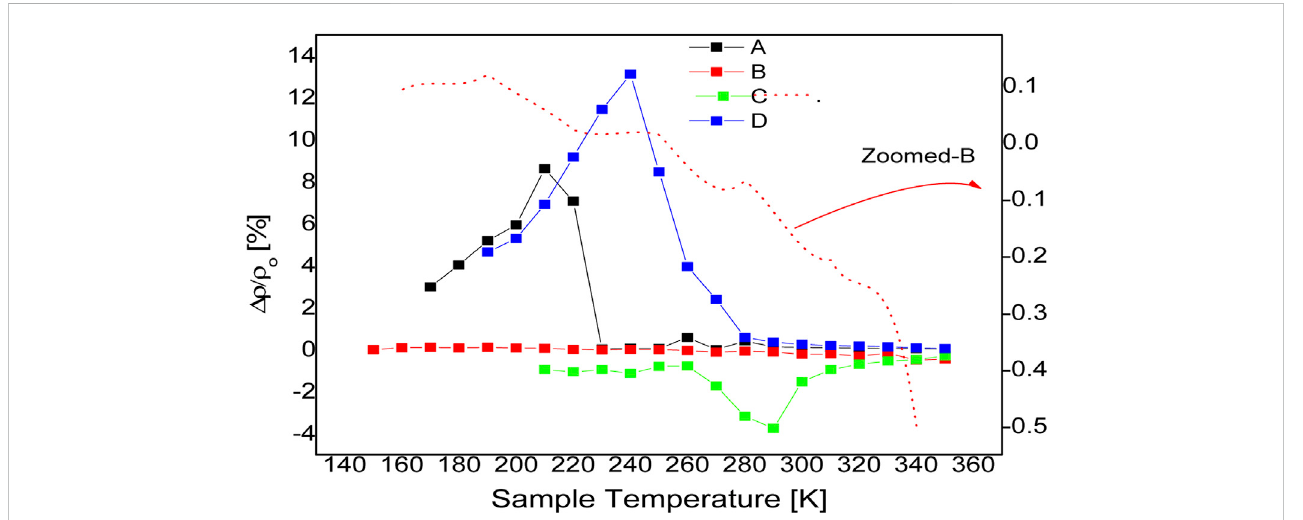
FIGURE 1 Temperature-dependent magnetoresistance studies were conducted for samples (A) , a pure ZnO pellet, (B) , (C) , and (D) , which, respectively, might include 2.5%, 5%, and 10% Fe in ZnO, applying resistance measurements during zero- fi eld cooling (zfc) and 9 T- fi eld